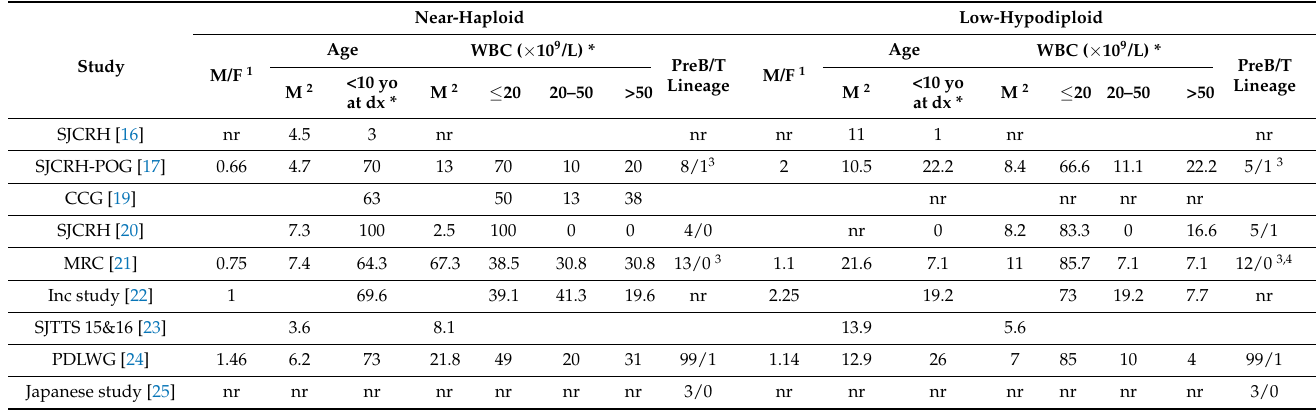
Table 2. Clinical and biological features of patients with hypodiploid